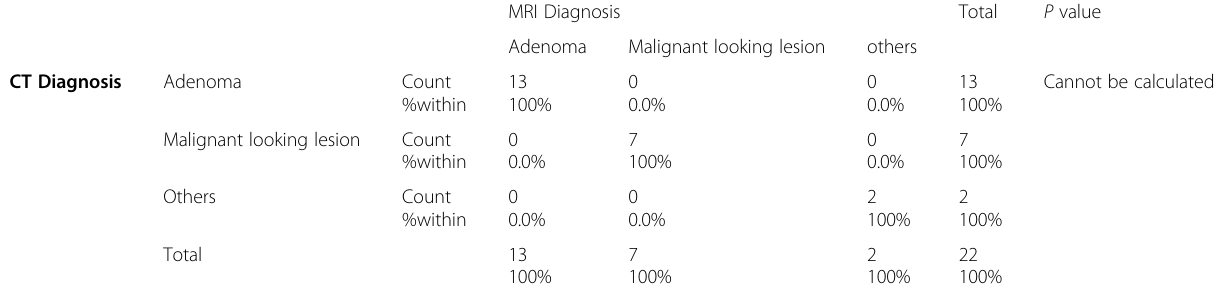
Table 5 CT_DIAGNOSIS * MRI_DIAGNOSIS Cross-tabulation